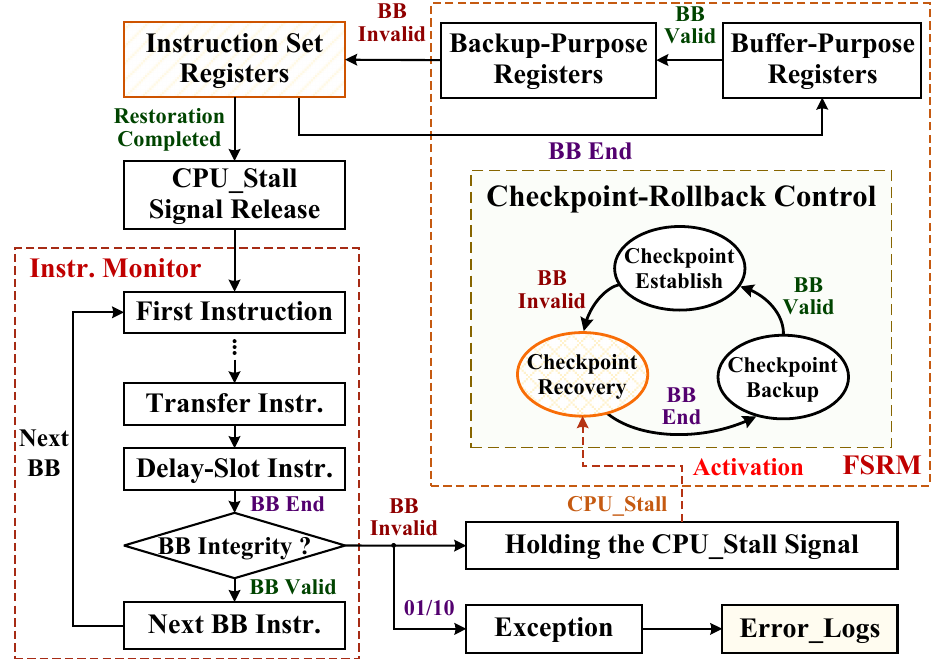
Figure 7. The overall control status diagram of instruction monitoring and